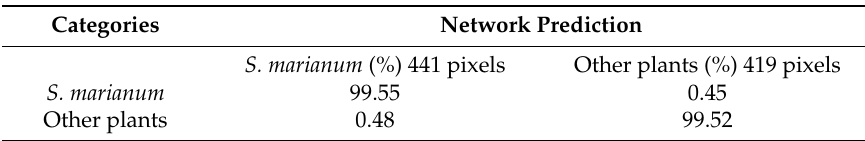
Table 1. Confusion matrix of the MLP-ARD for S. marianum and other plants. Percentages are estimated on actual observation